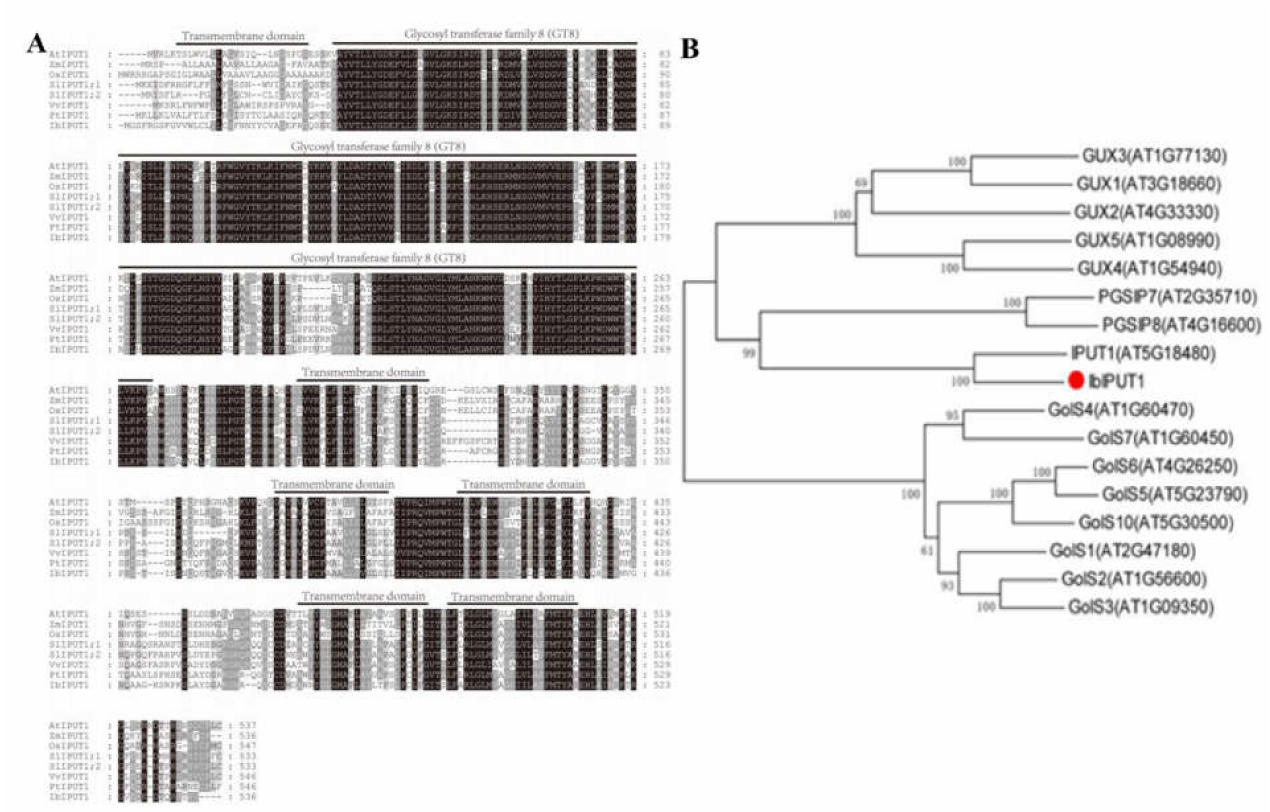
Figure 1. Molecular characterization of sweet potato IbIPUT1 protein. ( A ) Comparison of com- plete IPUT1 protein sequences in different species. The IPUT1 sequences included IbIPUT1 from sweet potato, AtIPUT1 from Arabidopsis (AT5G18480), ZmIPUT1 (GRMZM2G166903) from Zea mays , OsIPUT1 (LOC_Os02g41520) from Oryza sativa, SlIPUT1 (Solyc05g055040 and Solyc04g009920) from Solanum lycopersicum , VvIPUT1 (GSVIVG01023535001) from Vitis vinifera and PtIPUT1 (Potri 013G049100) from Populus trichocarpa . ( B ) Phylogenetic trees of IbIPUT1 and its homologs in Arabidopsis